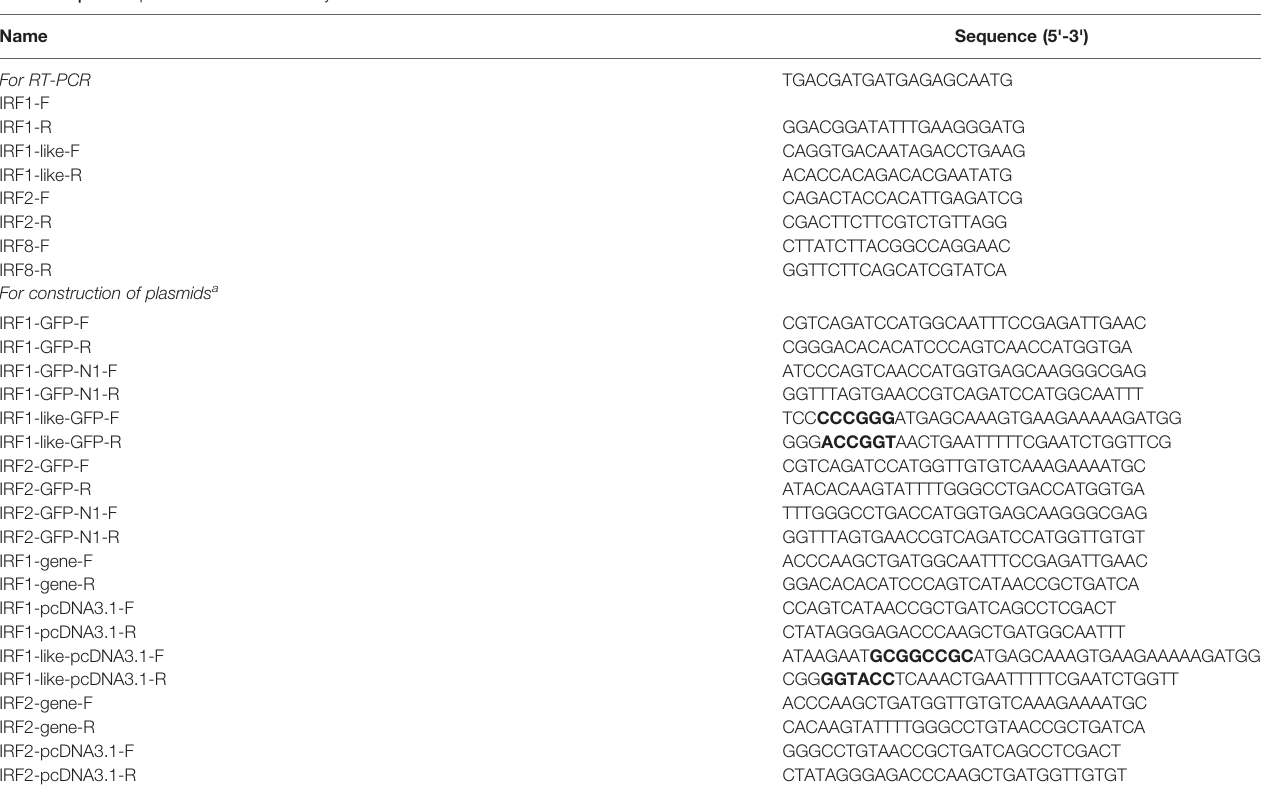
TABLE 1 | List of primers used in this